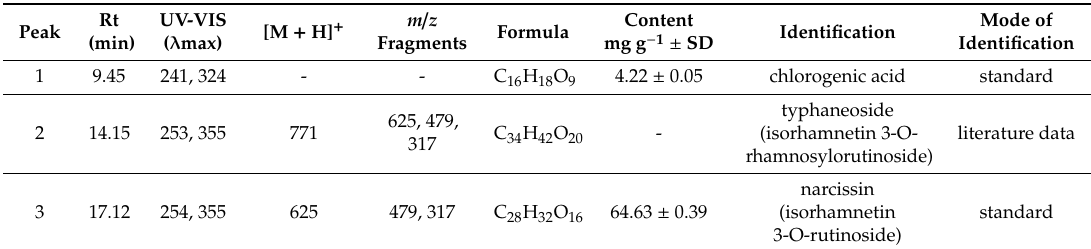
Figure 3. The chromatogram of 1—chlorogenic acid, 2—typhaneoside, and 3—narcissin, presented in the Calendulae flos lyophilized extract. Table 2. Identification phenolic compounds corresponding to the chromatographic peaks in Figure 3 by the UHPLC-DAD and UHPLC-MS/MS methods.